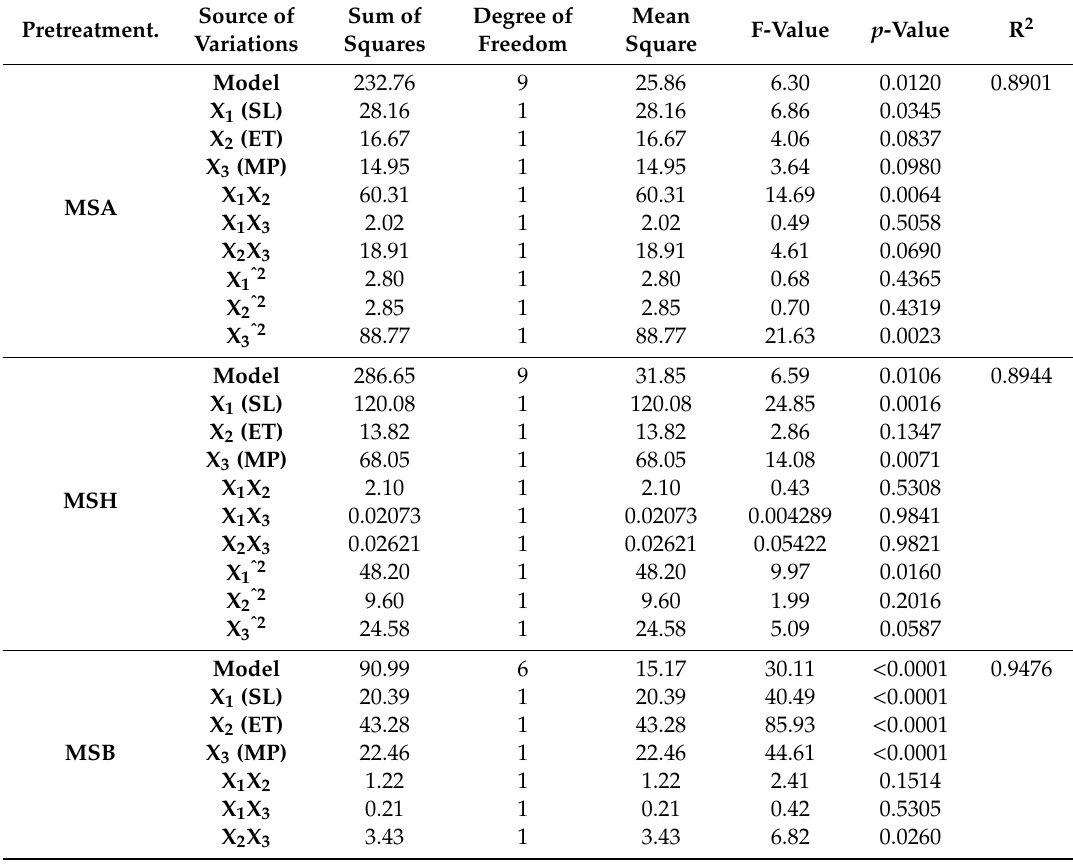
Table 4. ANOVA for glucose of MSA, MSH, and MSB pretreatments.